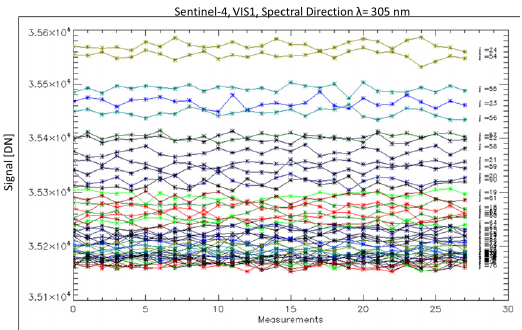
Figure 8. Signal over time for different slit positions